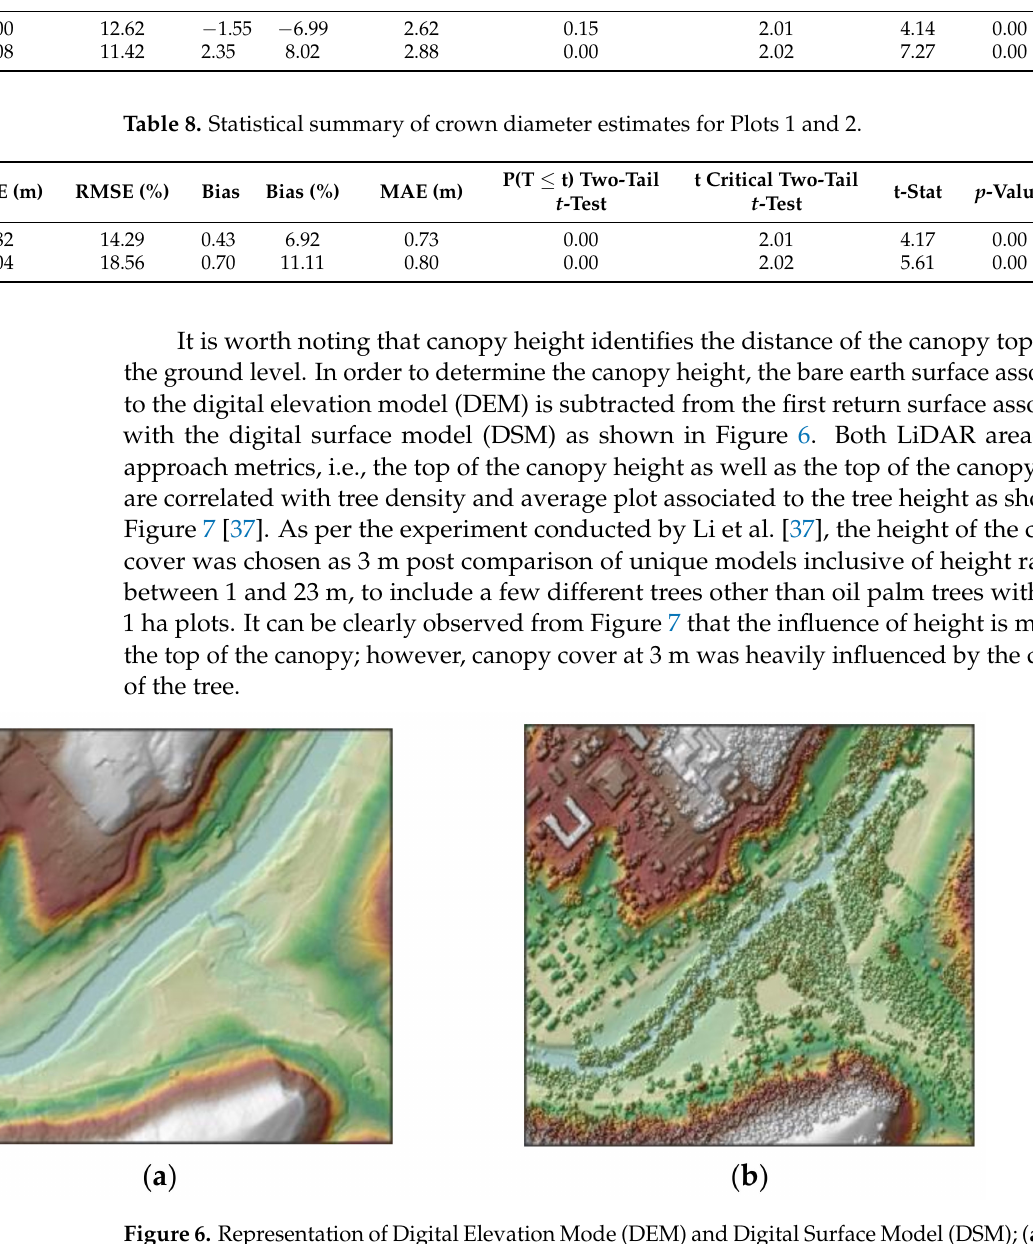
Figure 6. Representation of Digital Elevation Mode (DEM) and Digital Surface Model (DSM); ( a ) DEM; ( b )